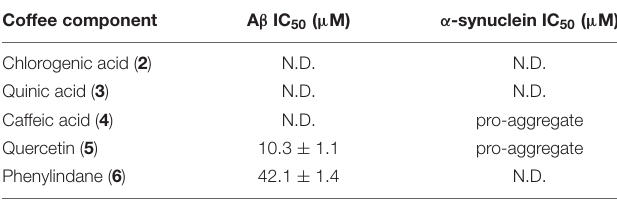
TABLE 5 | IC 50 values of coffee components 2 – 6 in oligomer assays.